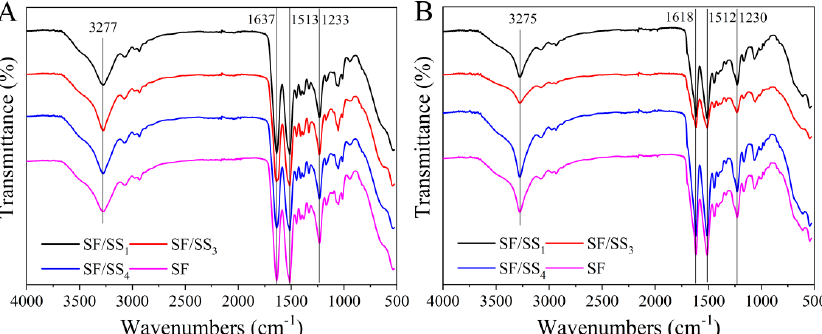
Figure 4. ATR − FTIR spectrum of SF/SS composite films. ( A ) No treatment, ( B ) Ethanol